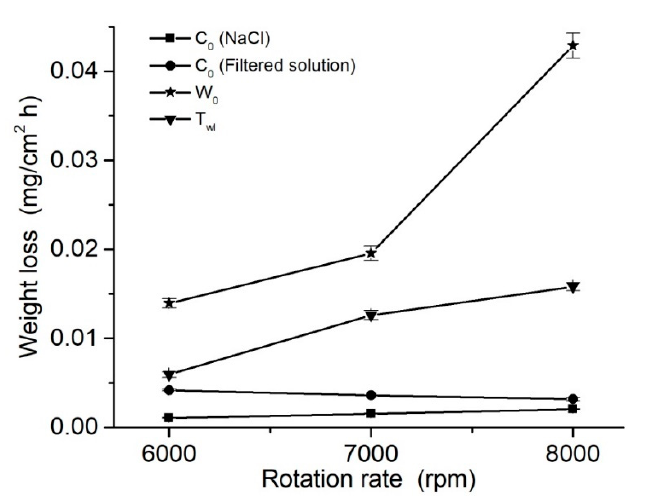
Figure 8. Individual weight loss rates for AISI 304L stainless steel in the absence and presence of erodent tailing particles at different rotation rates. The scatters in the weight loss results were less than ± 6.5% of the average value.